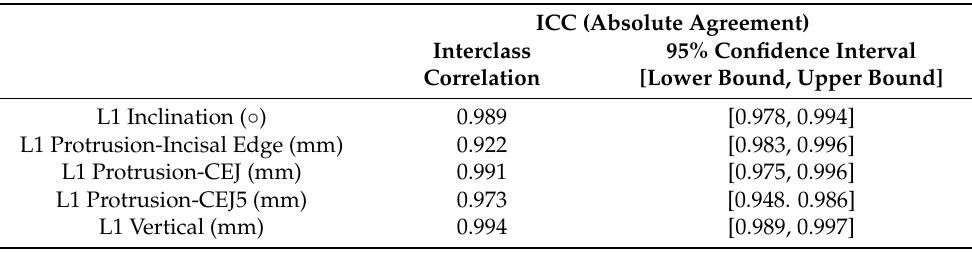
Table 2. The Interclass Correlation test results of each parameter.